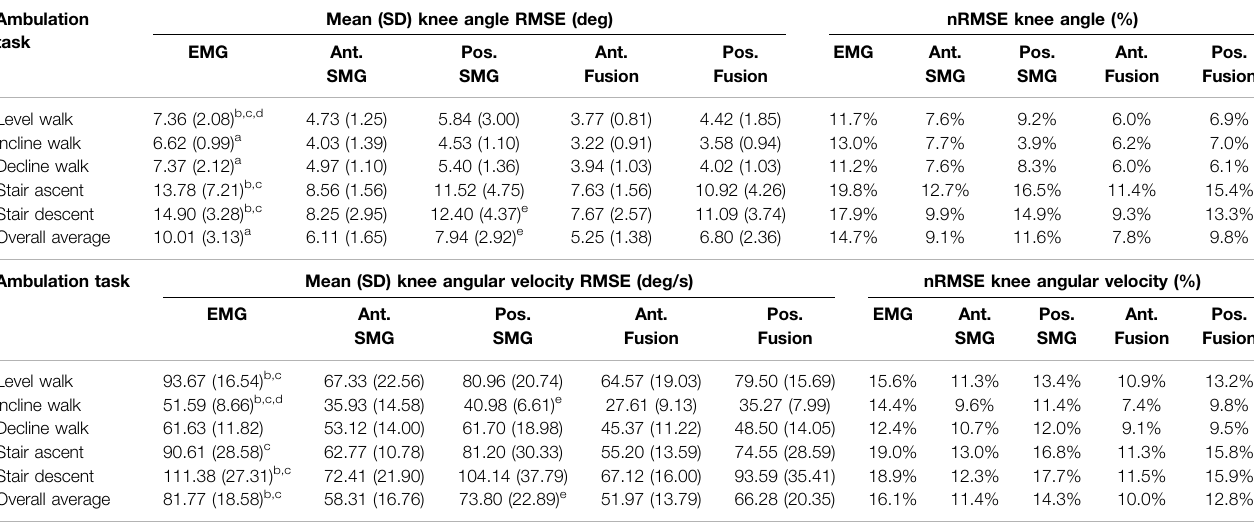
TABLE 3 | Mean (SD) root mean square error (RMSE) and range-normalized RMSE of knee angle and angular velocity during level walking, incline walking, decline walking, stair ascent and stair descent. Joint kinematics were predicted by Gaussian process regression models trained and tested on features from fi ve sensing modalities: 1) surfaceelectromyography(EMG),2)anteriorsonomyography(Ant.SMG),3)posteriorsonomyography(Pos.SMG),4)sensorfusionofAnt.SMGwithEMG(Ant.Fusion),and 5) sensor fusion of Pos. SMG with EMG (Pos. Fusion). Overall average values are mean across all ambulation